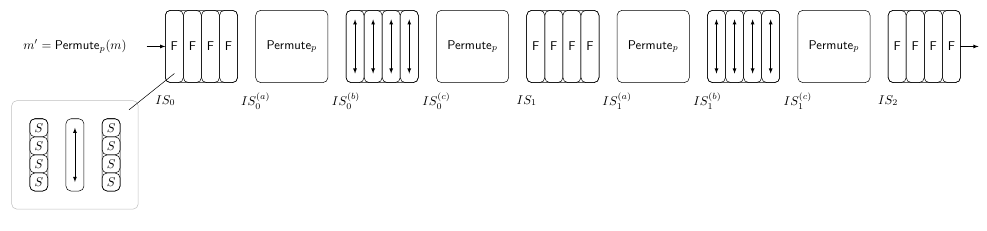
Figure 5: The three-round Super S-box SP cipher SE K , 3 : An equivalent representation of the six-round AES-like cipher employing a cell permutation p and the MixColumns matrix of Midori